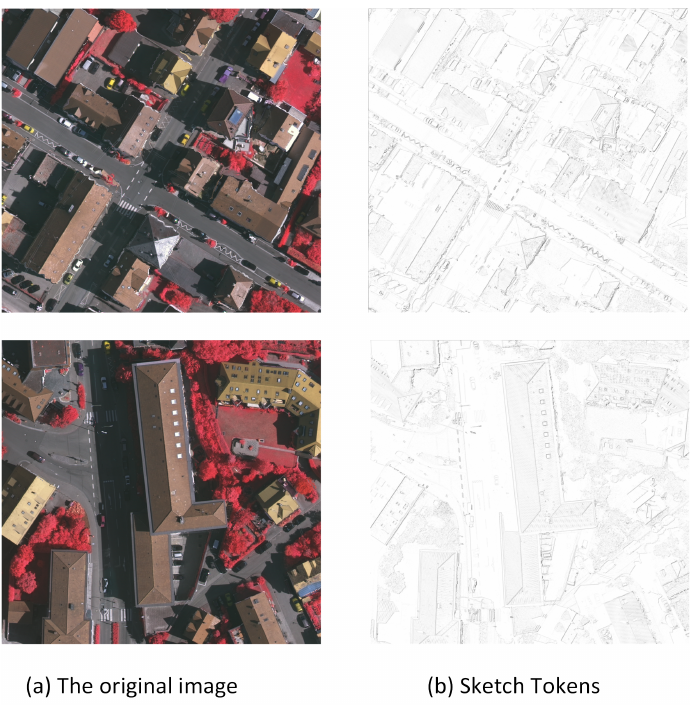
Figure 5. lThe figure shows the edge detection results of some images in the Vaihingen dataset using Sketch token edge detection